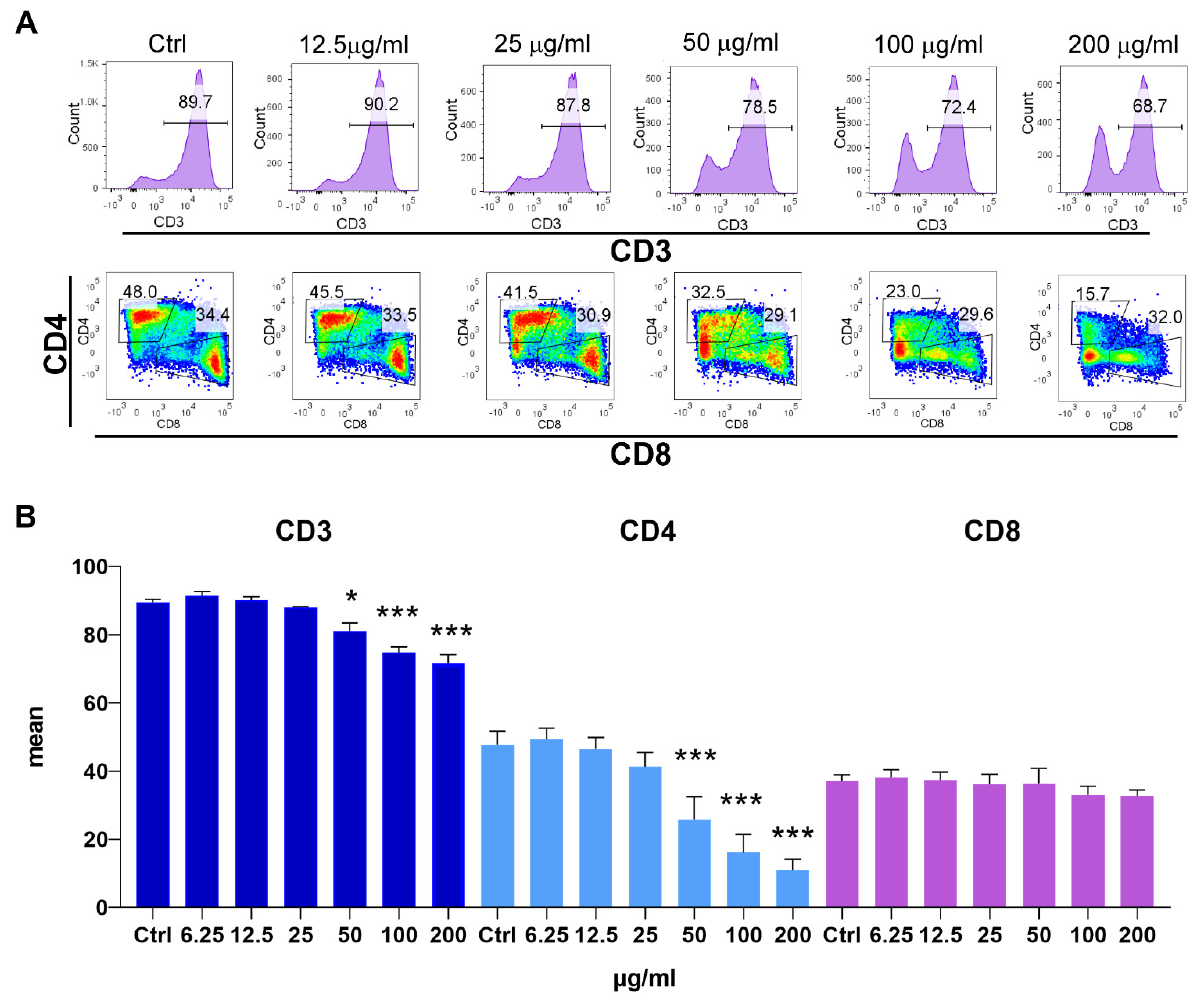
Figure 6. The effects of PoPEx on CD3, CD4 and CD8 expression in PHA-stimulated PBMC. PBMC (3 × 10 5 /well) pre-labeled with CellTrace Far-Red were cultured with PoPEx (6.25–200 µg/mL) or without PoPEx (ctrl), and PHA (10 µg/mL) for 3 days, followed by the analysis of CD3, CD4 and CD8 expression within gated lymphocytes (excluded doublets and cell debris). ( A ) A representative data on CD3 expression within lymphocytes (upper row) and CD4/CD8 co-expression (within 100% CD3 + cells) (lower row) is shown, and ( B ) the summarized data is shown as mean ± SD from three independent experiments * p < 0.05, *** p < 0.005, compared to control non-treated PHA-PBMC (Friedman test; Dunn’s multiple comparison